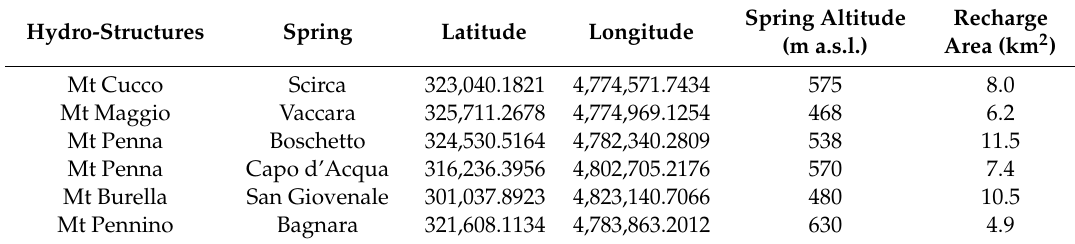
Table1. Generalcharacteristicsofthecarbonatecomplexesandtheirrelatedcatchmentareas(geographic coordinates are expressed in WGS84 UTM Zone